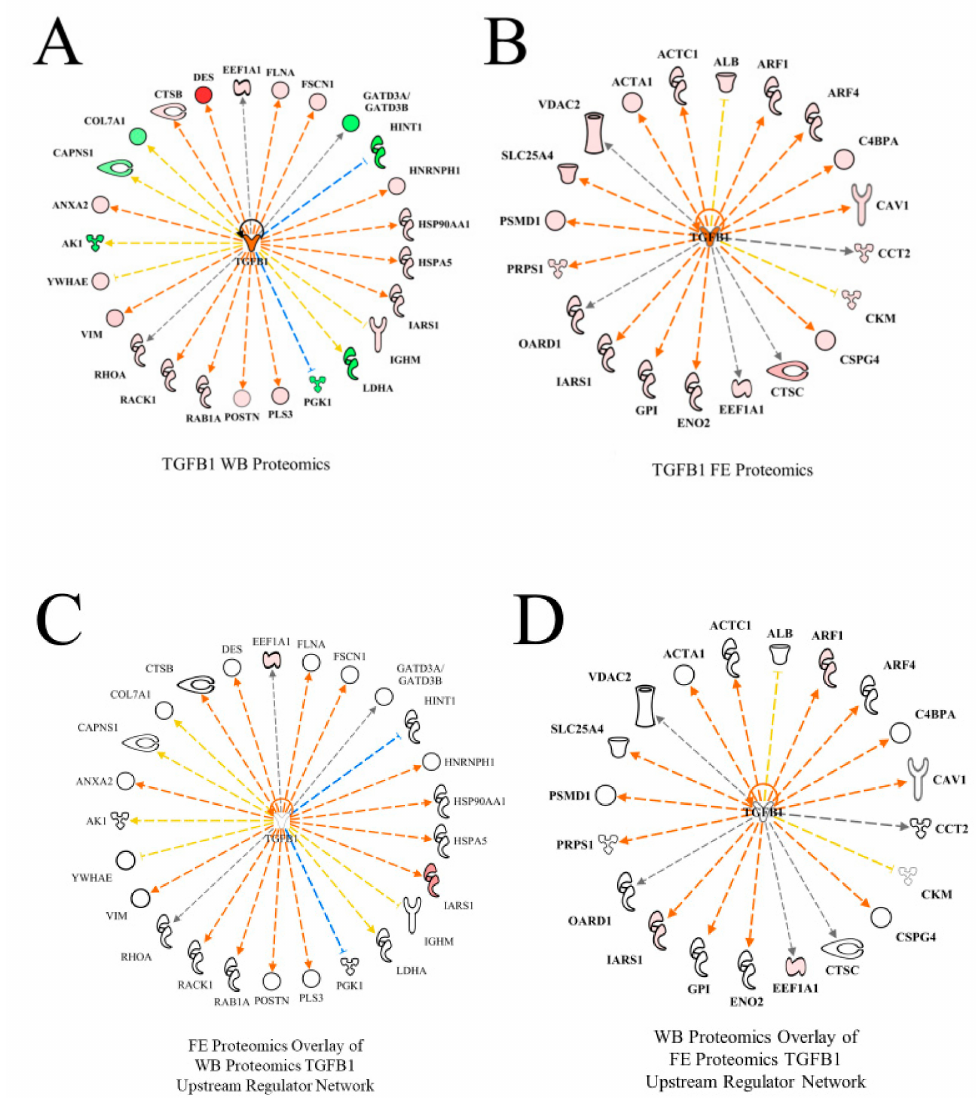
Figure 6. The upstream regulatory network of transforming growth factor beta 1 (TGFB1) for wooden breast (WB) ( A ) and feed efficiency (FE) ( B ) proteomic datasets. Downstream target proteins that were differentially expressed are shown as up-regulated in pink or red or down-regulated in WB myopathy and high FE PedM broilers. Overlay of the FE proteomic dataset on the WB myopathy network ( C ) and of the FE data on the WB network ( D ) resulted in predicted activations of TGFB1 as well. Therefore, despite dissimilar proteomic landscapes of the two datasets, TGFB1 is predicted to be active in both WB myopathy and high